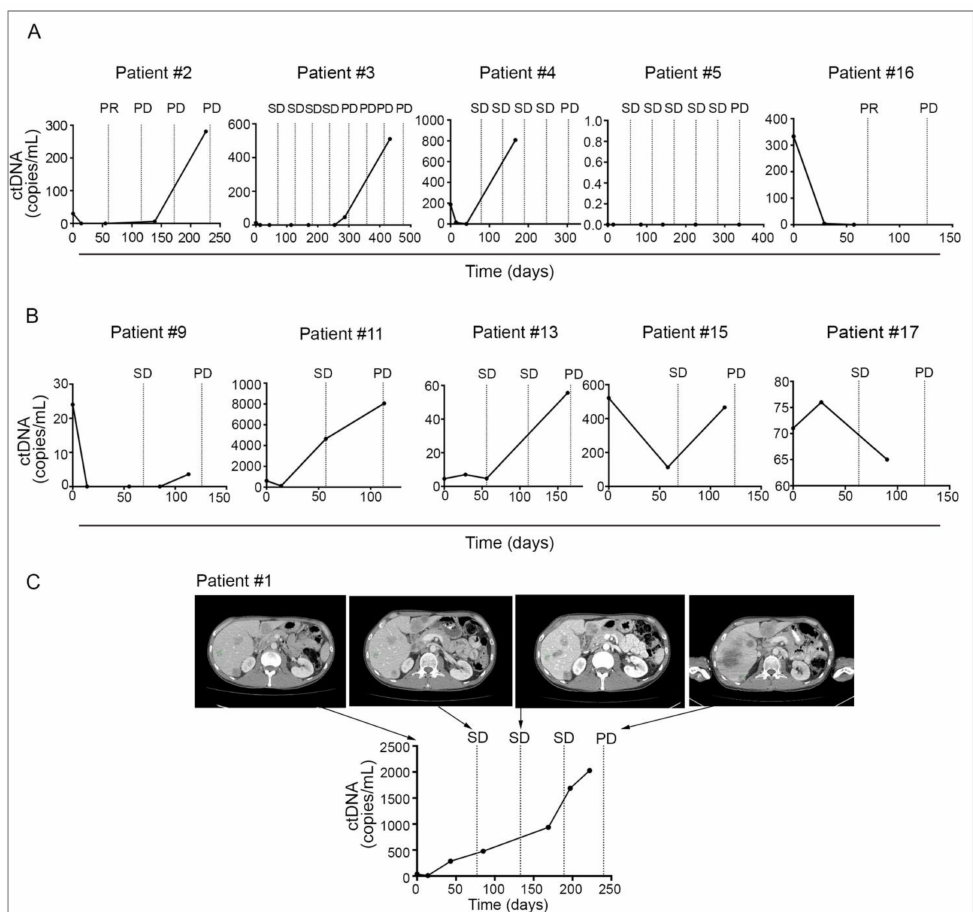
Figure 3. Monitoring of ctDNA in patients treated with PKCi in metastatic UM. ctDNA levels were collected longitudinally during treatment and correlated to CT imaging during baseline, whilst on treatment and on progression. Longitudinal ctDNA monitoring is shown for ( A ) clinical benefit patients, ( B ) no clinical benefit patients and ( C ) CT images and corresponding ctDNA data are shown for clinical benefit patient #1. Only patients #2, #3, #4, #5, #9 and #16 had undetectable ctDNA for the driver oncogene in at least one on-therapy plasma sample. SD, stable disease; PR, partial response; PD, progressive